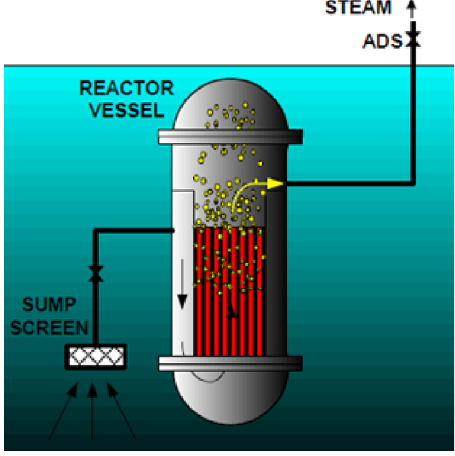
Fig. 26. Core cooling by sump natural